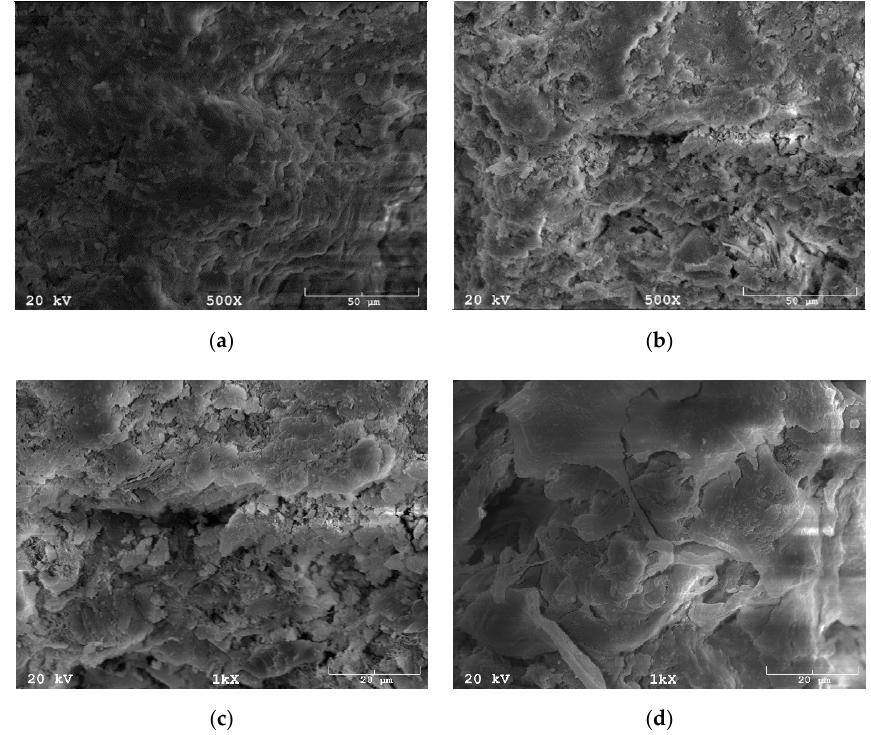
Figure 3. Microstructure of the ternary binder detected by SEM in magnification of 500x and 1000x. ( a , c ) GCP-phosphogypsum (PG), ( b , d )